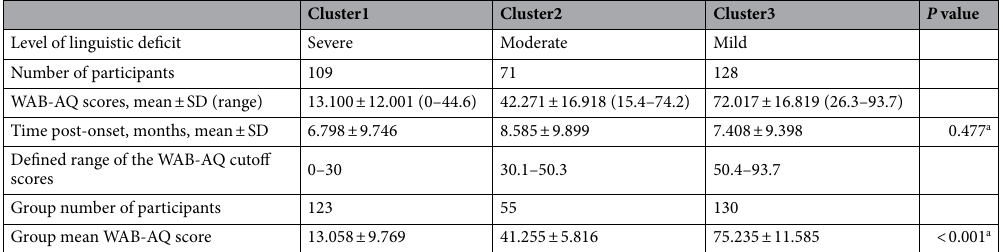
Table 2. Characteristics of the clusters. SD standard deviation, WAB-AQ aphasia quotient of Western Aphasia Battery. a 1-way analysis of